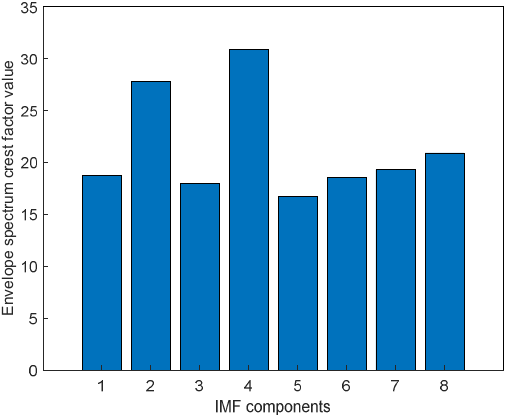
Figure 16. Each component’s envelope spectrum crest factor value. Through the plot of each component amplitude of each component in Figure 16, it can be seen that IMF4 has the largest value of the envelope spectrum peak factor; therefore, IMF4 is selected as the optimal component. Envelope spectrum analysis is performed for IMF4, and the results are shown in Figure 17.